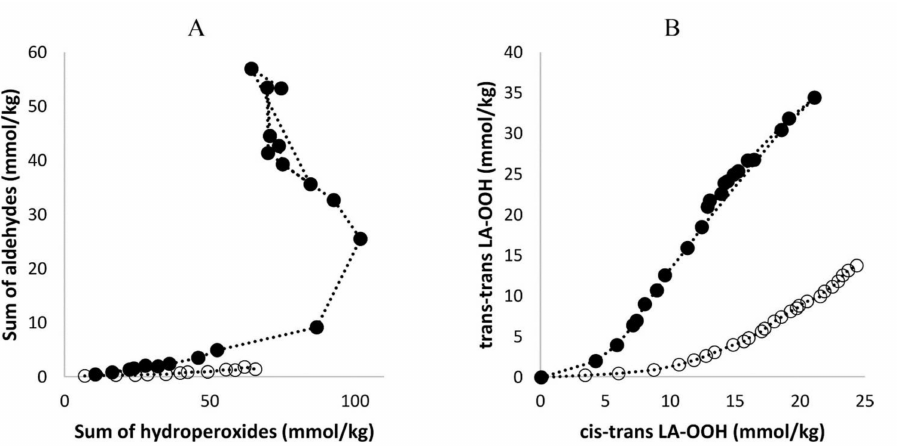
Figure 37. Map of oxidation trajectories at elevated ( • ) and ambient ( and 203 days, respectively. ( A ) Plot of aldehydes vs hydroperoxides (PC2 visualized); ( B ) Plot of trans − trans -LA-OOH vs. cis − trans -LA-OOH (PC3 visualized). Reprinted with permission from [135]. Copyright 2018, American Chemical